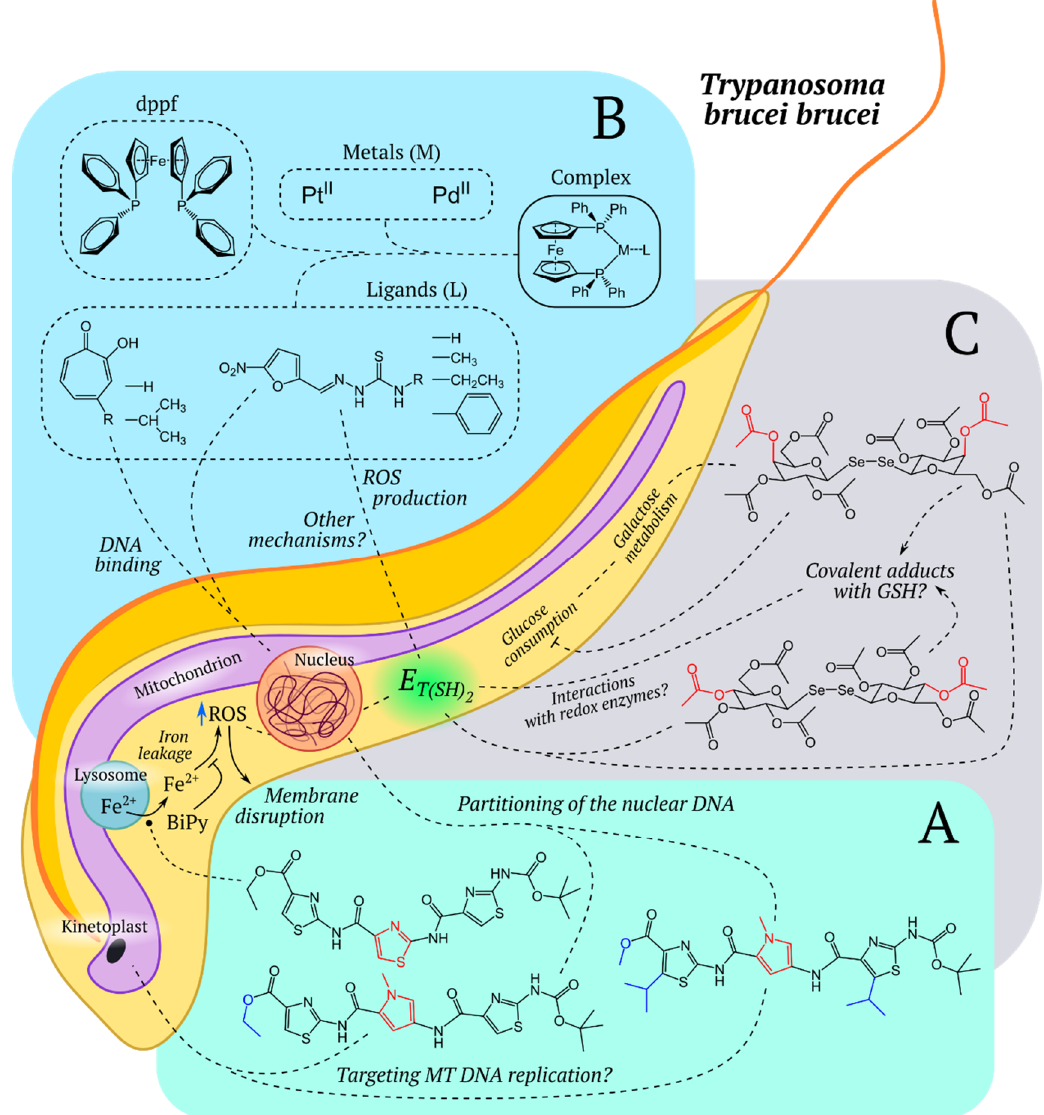
Figure 9. Several anti-trypanosomal compounds were tested for their ability to affect redox homeostasis in Trypanosoma brucei brucei . Interestingly, in many cases, small variations in the molecular structure of a drug (highlighted in color) lead to a dramatic change in the mechanism of its functioning. ( A ) Anti-trypanosomal tri-thiazoles linked by amide [227,231]. ( B ) Anti-trypanosomal organometallic compounds [229,230]. ( C ) Anti-trypanosomal sugar diselenides [228]. Abbreviations: dppf—1,1′-bis(diphenylphosphino) ferrocene; E T(SH)2 —trypanothione redox potential; GSH—reduced glutathione; MT DNA—mitochondrial DNA; ROS—reactive oxygen species.